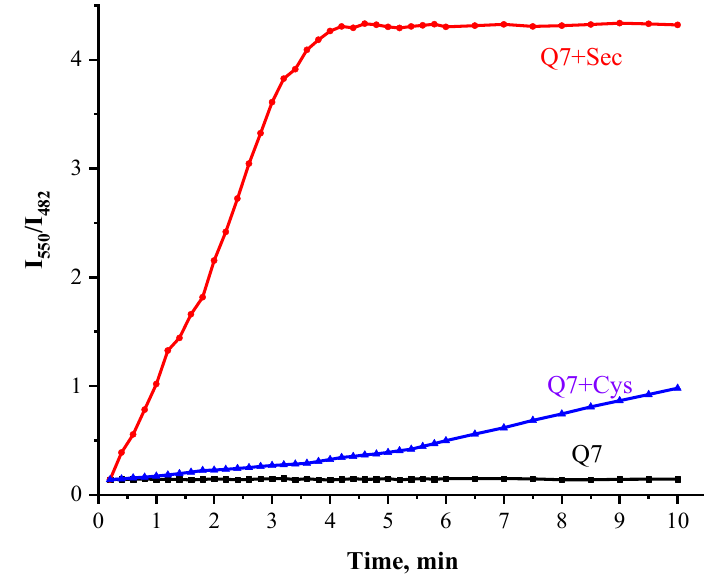
Figure 3. Effect of time on Fluorescent intensity ratios I 550 /I 482 of 1 μ M Q7 (black), Q7 reacting with 100 μ M Sec (red) and Q7 reacting with 1 mM Cys (blue) in DMSO/PBS = 1:99 ( v / v ), excited at 400 nm.